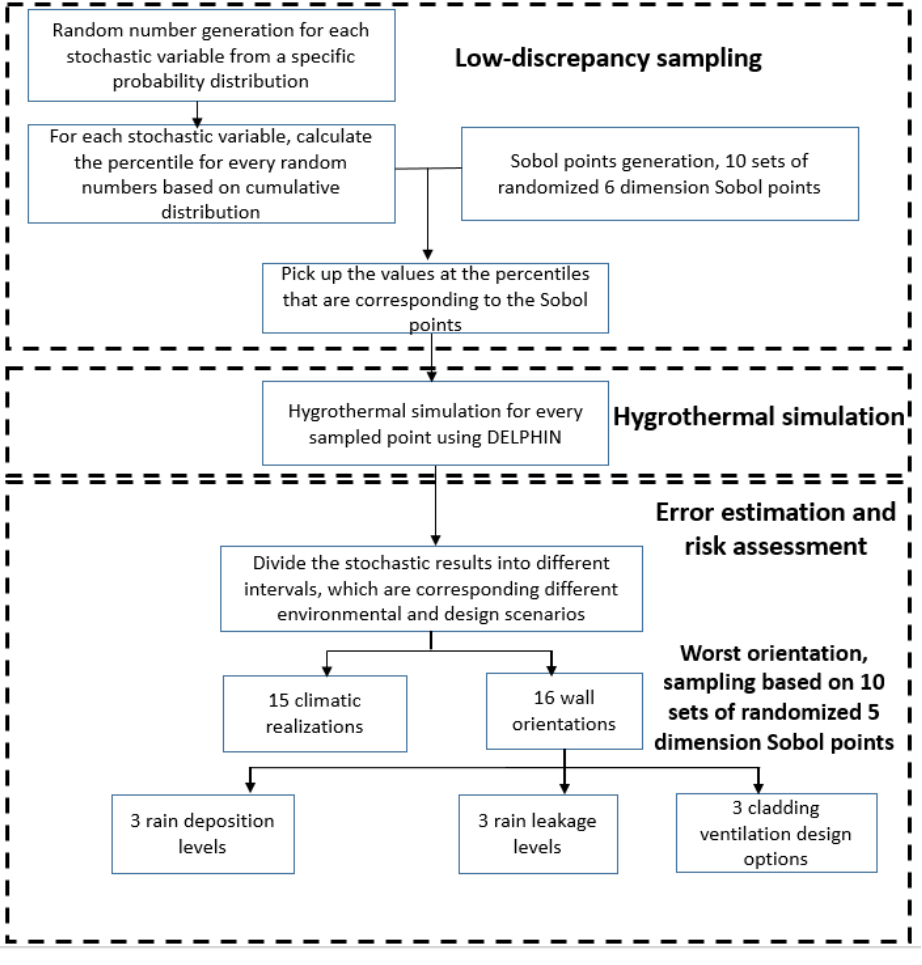
Figure 10. The overall procedure of stochastic simulation.